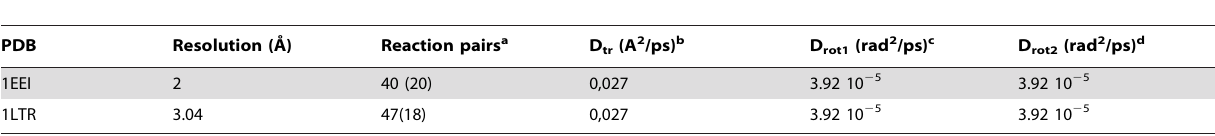
a Number of intermolecular donor-acceptor pairs within 5 A˚ in the crystal structure of the complex. The number of independent donor-acceptor pairs is given in parentheses. b Relative translational diffusion coefficient. c Rotational diffusion coefficient of protein 1. d Rotational diffusion coefficient of protein 2. doi:10.1371/journal.pone.0015347.t001 PLoS ONE |